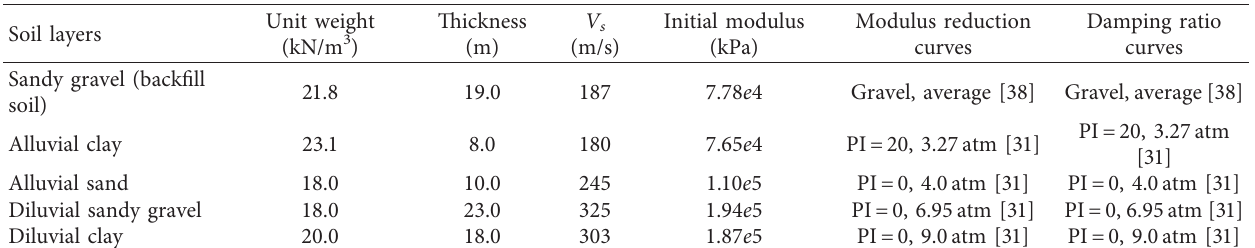
Figure 11: The soil profile of the Port island case developed by Inagaki [37]. Table 7: Soil parameters used for nonlinear effective